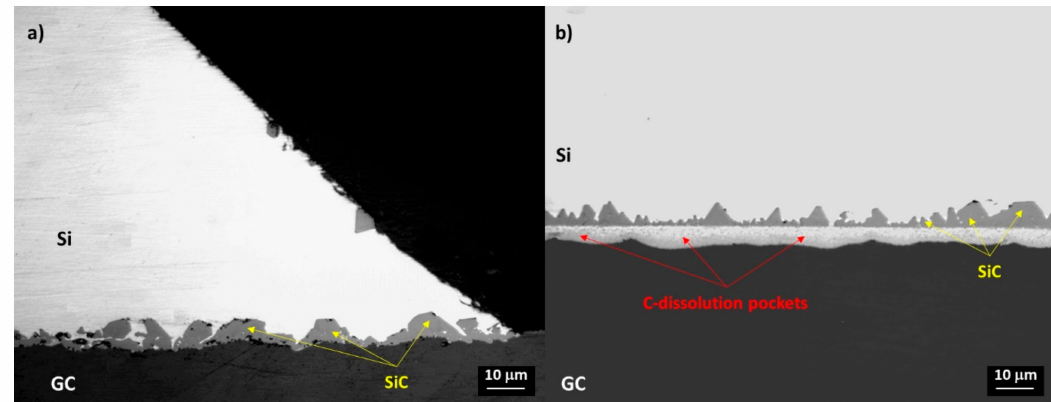
Figure 4. Light microscopy (LM) images at the cross-sectioned Si / GC sample after the wetting test performed at T = 1450 ◦ C under a static Ar atmosphere for 15 min: ( a ) triple line; ( b ) middle of the sample.